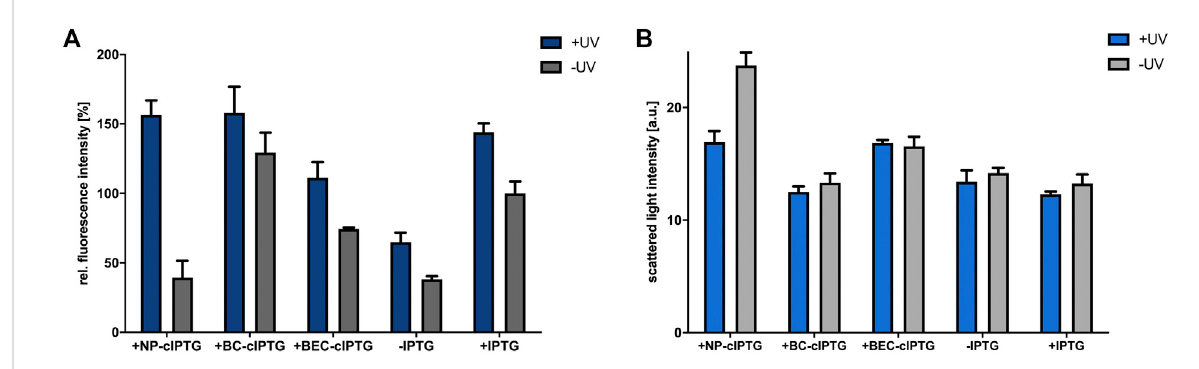
FIGURE 3 Application of cIPTG derivatives for light-controlled induction of gene expression in phototrophically grown R. capsulatus cells. Light- controlled eyfp reporter gene expression (A) and corresponding cell densities (B) of phototrophically grown R. capsulatus SB1003 cells carrying pRholHi-2-eYFPusingthecIPTGderivativesNP-,BC-andBEC-cIPTG.Biomass-normalized eYFP invivo fl uorescence( λ ex =508 nm, λ em =532 nm) andcellgrowth representedbythescatteredlightintensityofculturessupplementedwith1 m M ofeachcIPTGvariantareshowninrelationtoa control culture (1 m M IPTG) after 48 h of cultivation [30 ° C, screw neck vials, constant NIR light illumination ( λ max = 850 nm, 1.7 mW/cm 2 )]. Induction of reporter gene expression was performed after 6 h via UV-A light exposure (365 nm; ~2 mW/cm 2 ) for 30 min. Values are means of individual biological triplicates. Error bars indicate the respective standard